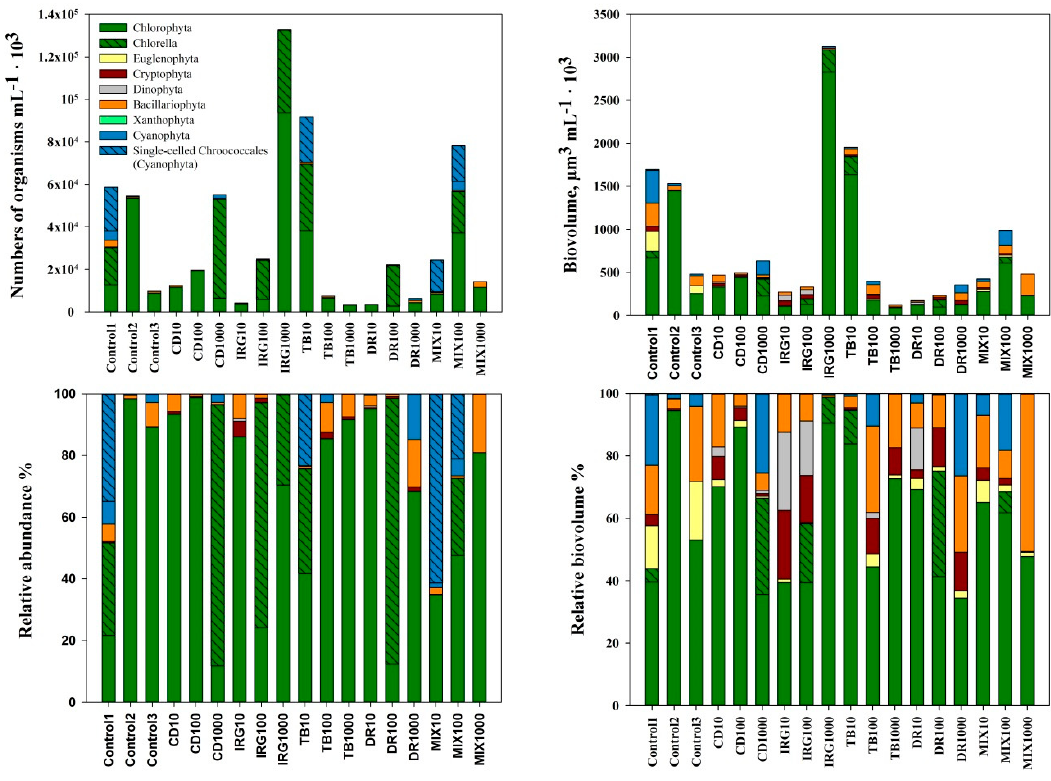
Figure 3. Phytoplankton taxa distribution in the sediment microcosm study. Absolute and relative values are given with respect to the counted numbers of organisms and the estimated biovolumes.